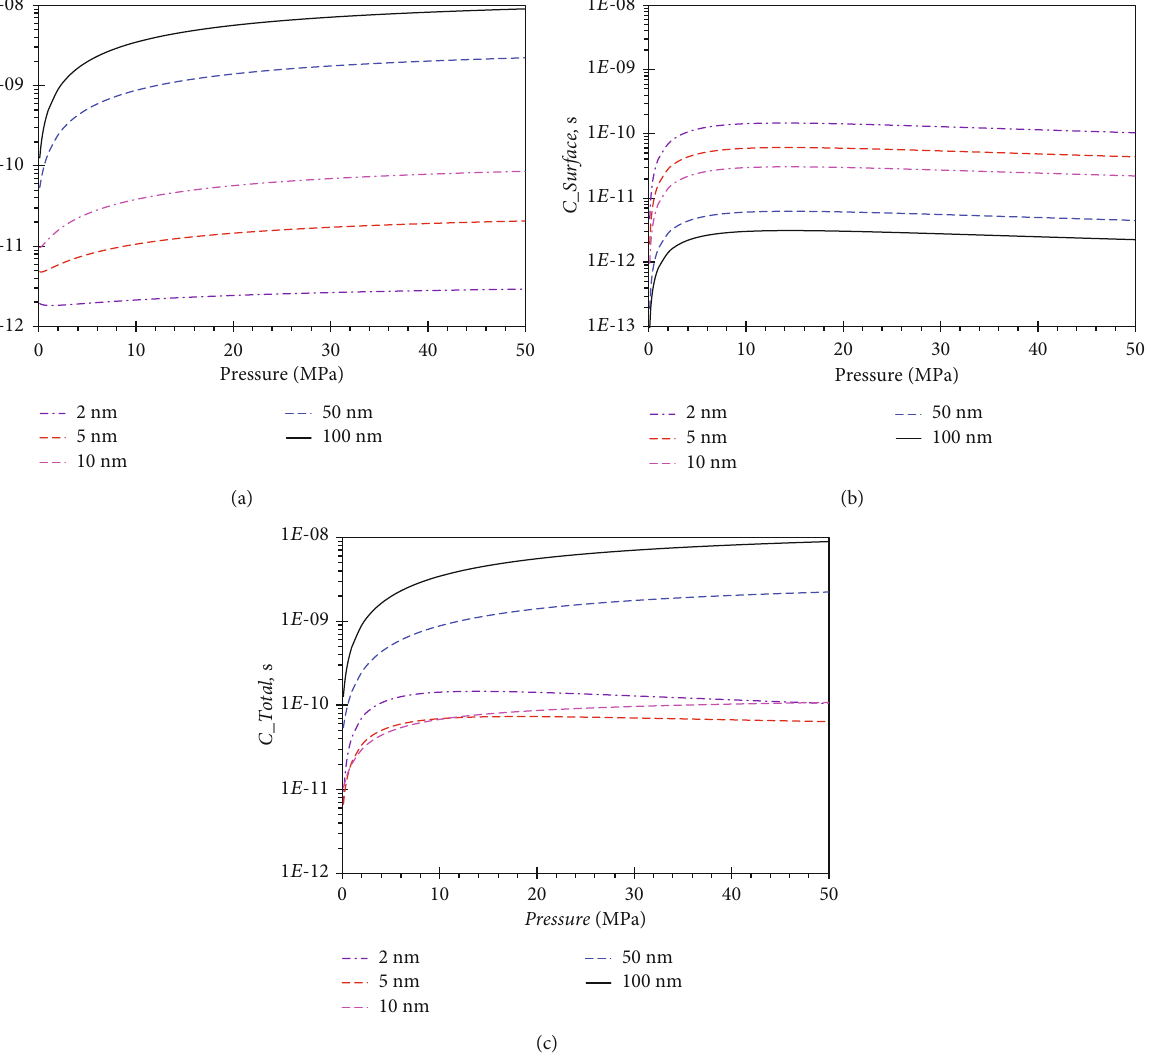
Figure 3: Nanocon fi ned gas fl ow behavior in the organic nanopore: (a) Bulk-like gas transport behavior; (b) Surface di ff usion of adsorption molecules; (c) Total gas